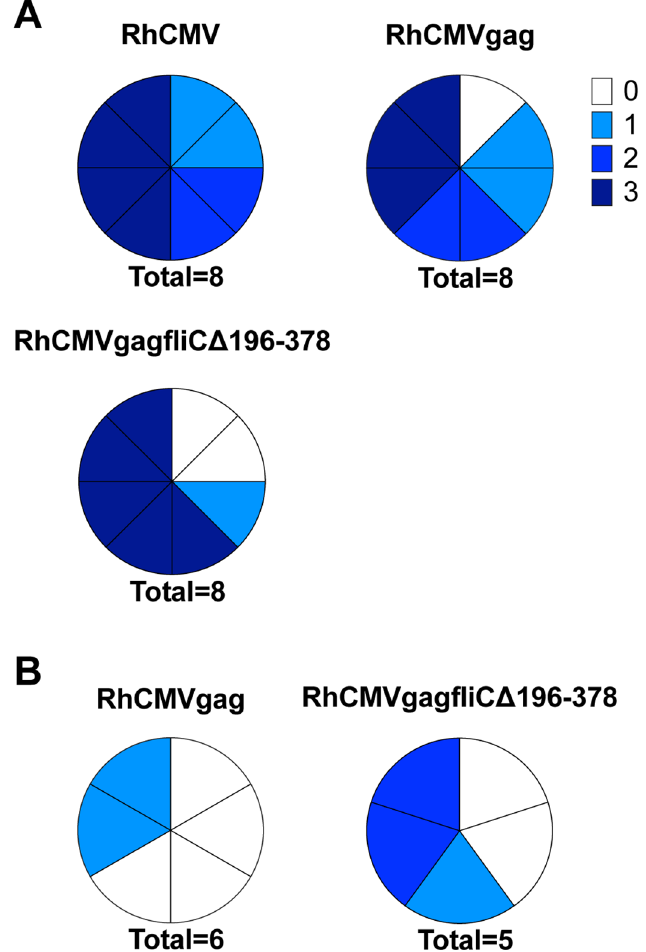
Fig 8. Inflammatory responses to RhCMV gagfliC Δ 196 – 378 in RhCMV macaques. (A) Eight RhCMV sero-negative macaques were inoculated with RhCMV, RhCMV gag , or RhCMV gagfliC Δ 196 – 378 and skin biopsies were collected seven days post-infection at the site of inoculation. (B) RhCMV sero-positive macaques were infected with either RhCMV gag (six macaques) or RhCMV gagfliC Δ 196 – 378 (five macaques) and skin biopsies were collected at the site of inoculation seven days post-infection. Slides generated from the skin biopsies were stained by H&E and scored for inflammatory cell infiltrates. Charts indicate the observed inflammation with 0 (white) representing no observed inflammation, 1 (light blue) representing mild inflammation, 2 (medium blue) representing moderate inflammation, and 3 (darkest blue) representing severe